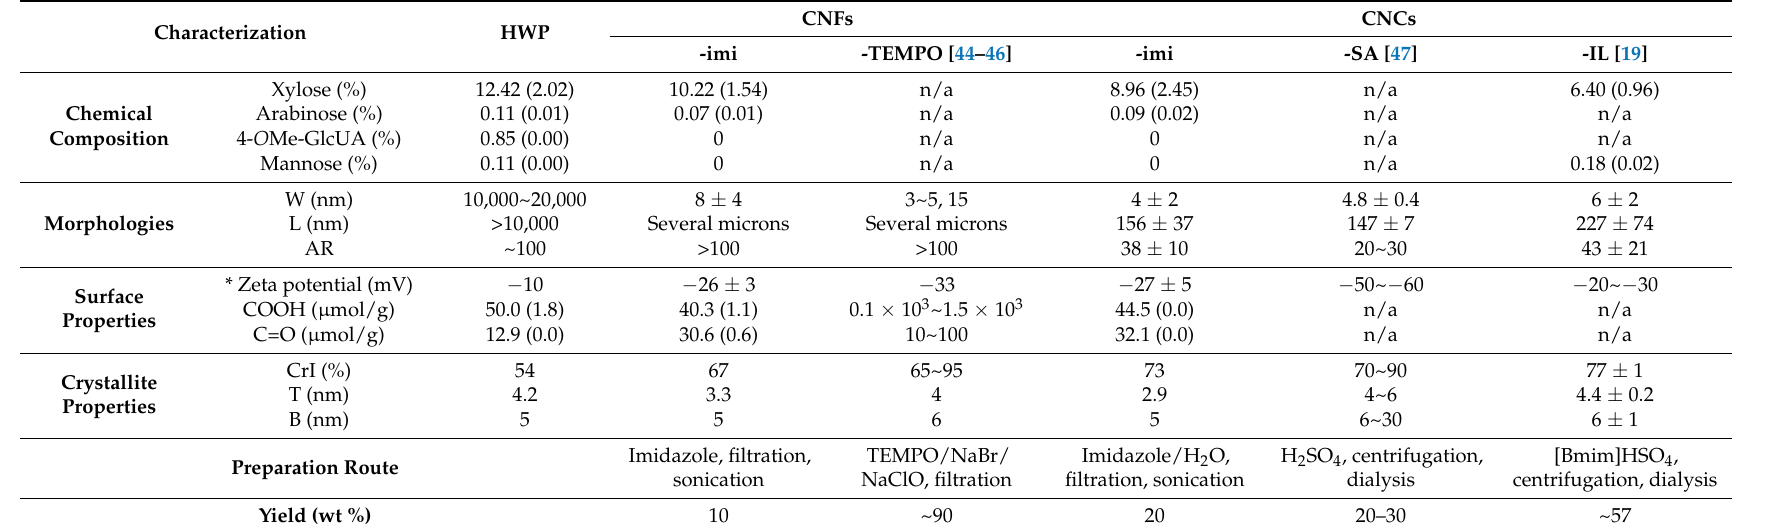
Table 1. Characteristics of the original hardwood pulp (HWP), CNCs obtained using sulfuric acid (-SA), [Bmim]HSO 4 (-IL), imidazole (-imi) and CNFs obtained using TEMPO-based system (-TEMPO) and imidazole